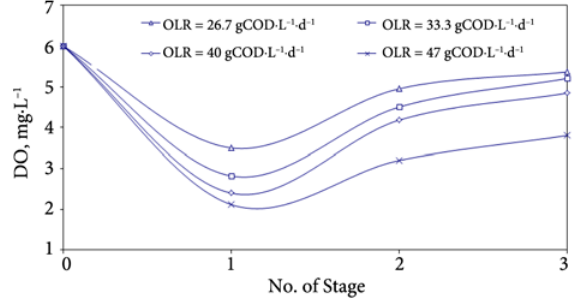
Fig. 3. DO concentration profiles in different stages of RBC with various